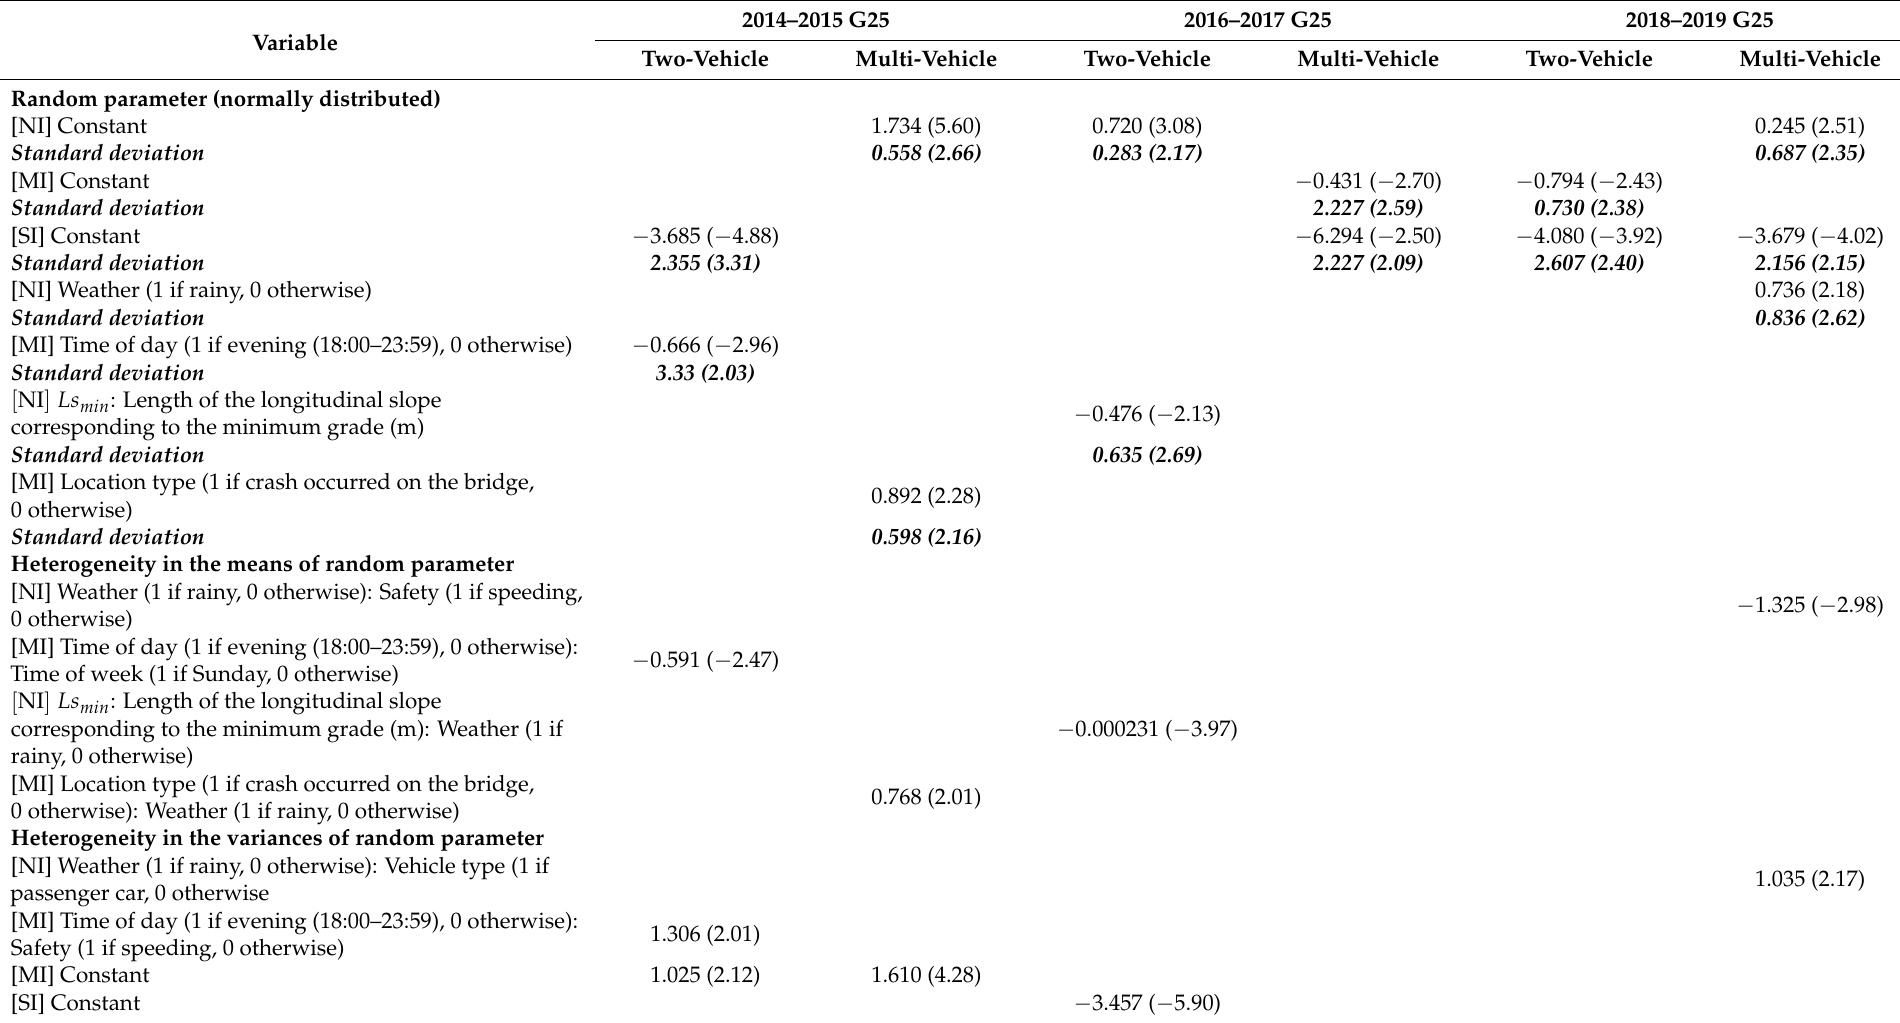
Table 5. Model results of crash severity in two-vehicle and multi-vehicle rear-end crashes in Changchun-Shenzhen Freeway (G25) ( t -stat. in parentheses).